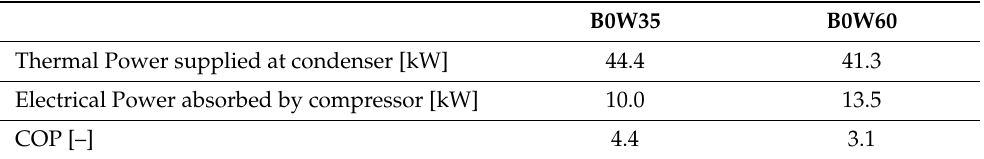
Table 3. Characteristics of the GSHP provided by the manufacturing company.